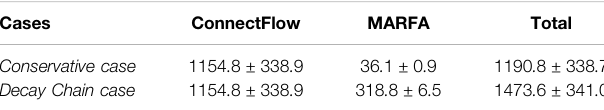
TABLE 5 | DFN model runtime in seconds for the Conservative case and Decay Chain case , calculated as a mean over 10 realisations ± 1 σ and separated into ConnectFlow and MARFA components.